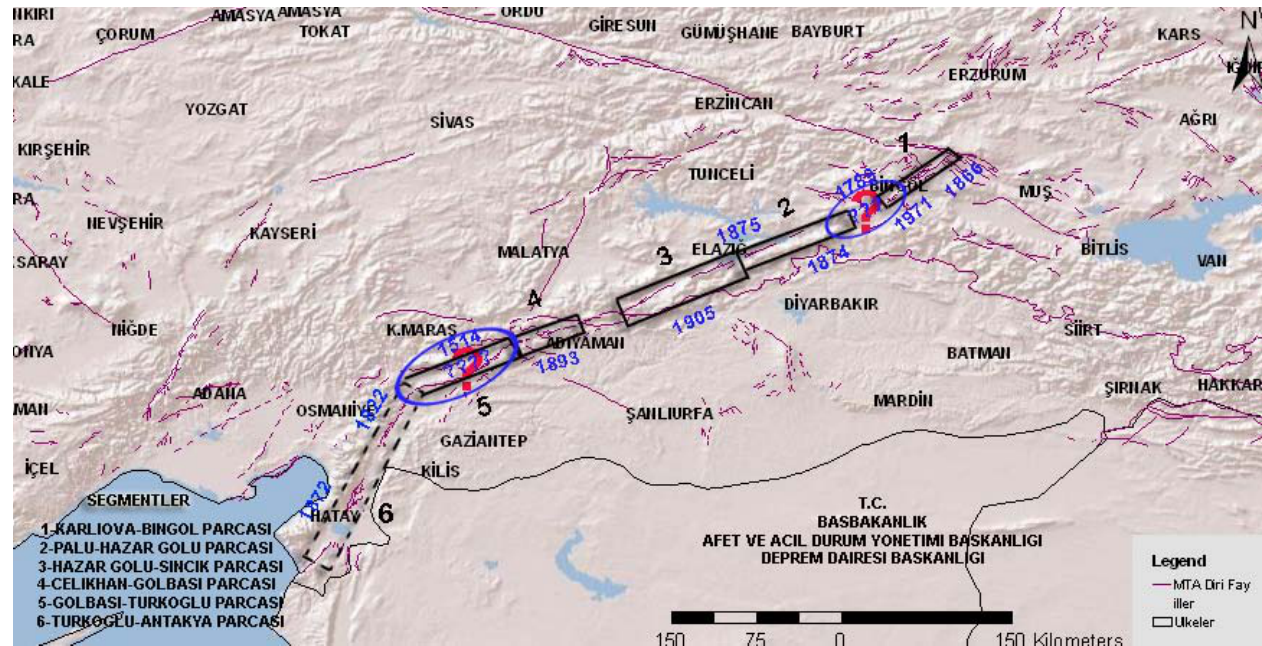
Fig. 2. EAFS and Karakocan-Elazig earthquake (ED,